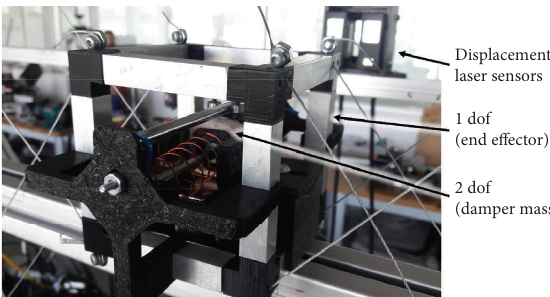
Figure 7: Photography of the frst and second degrees of Table 1: Dynamic system parameters.